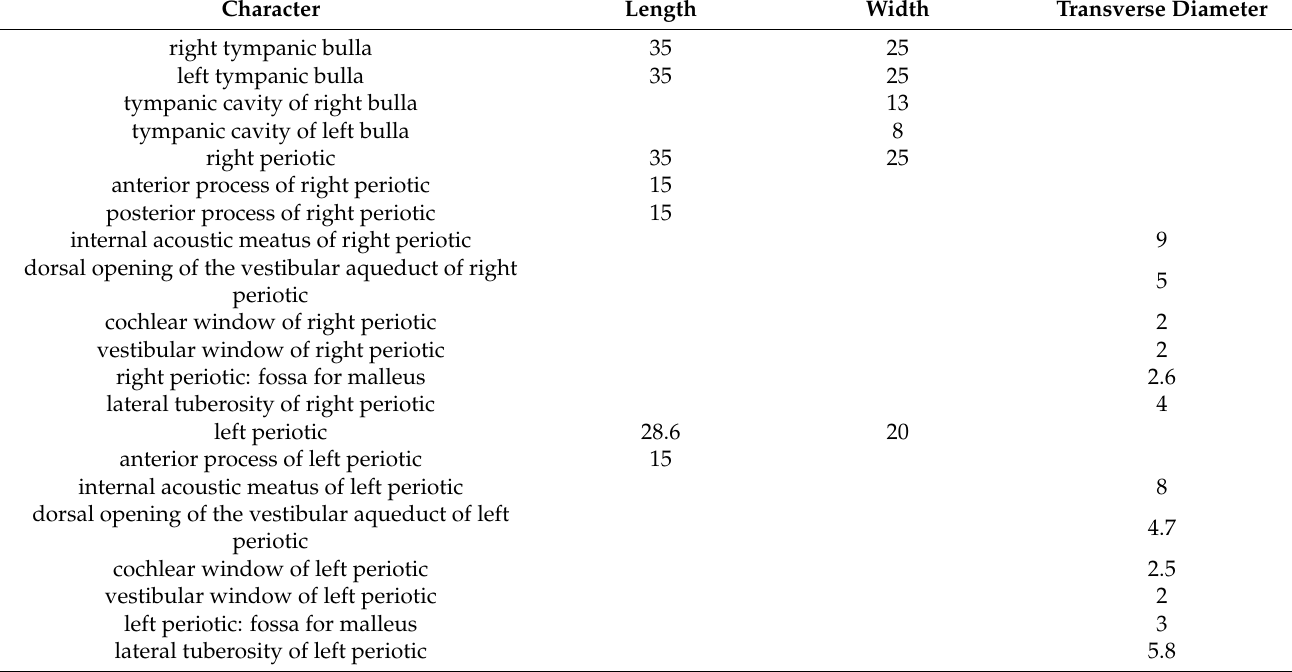
Table 5. Measurements in mm of 13881/2, 13906: Tympanic bullae and